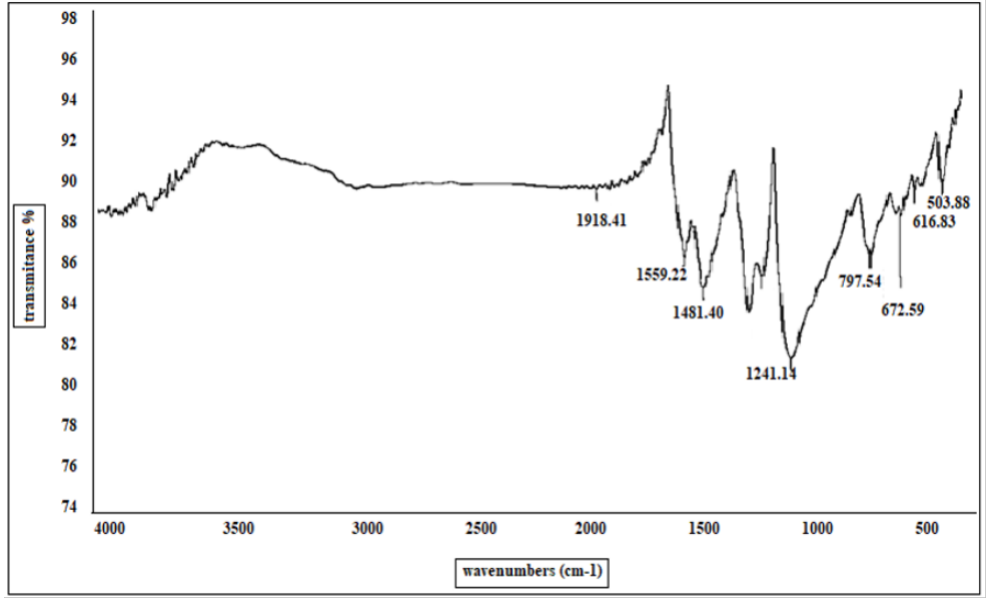
Figure 5. IR spectrum of the prepared